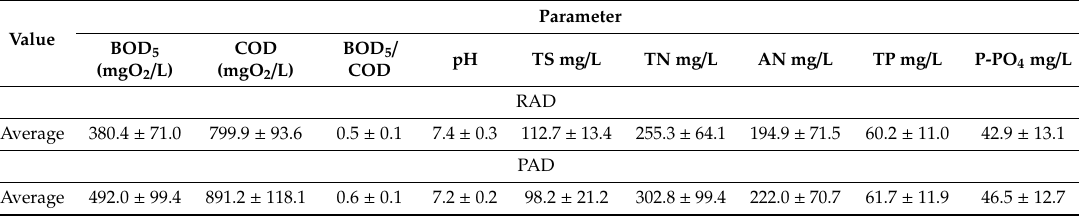
Table 1. Characteristics of the raw anaerobic digestate from the upflow anaerobic sludge